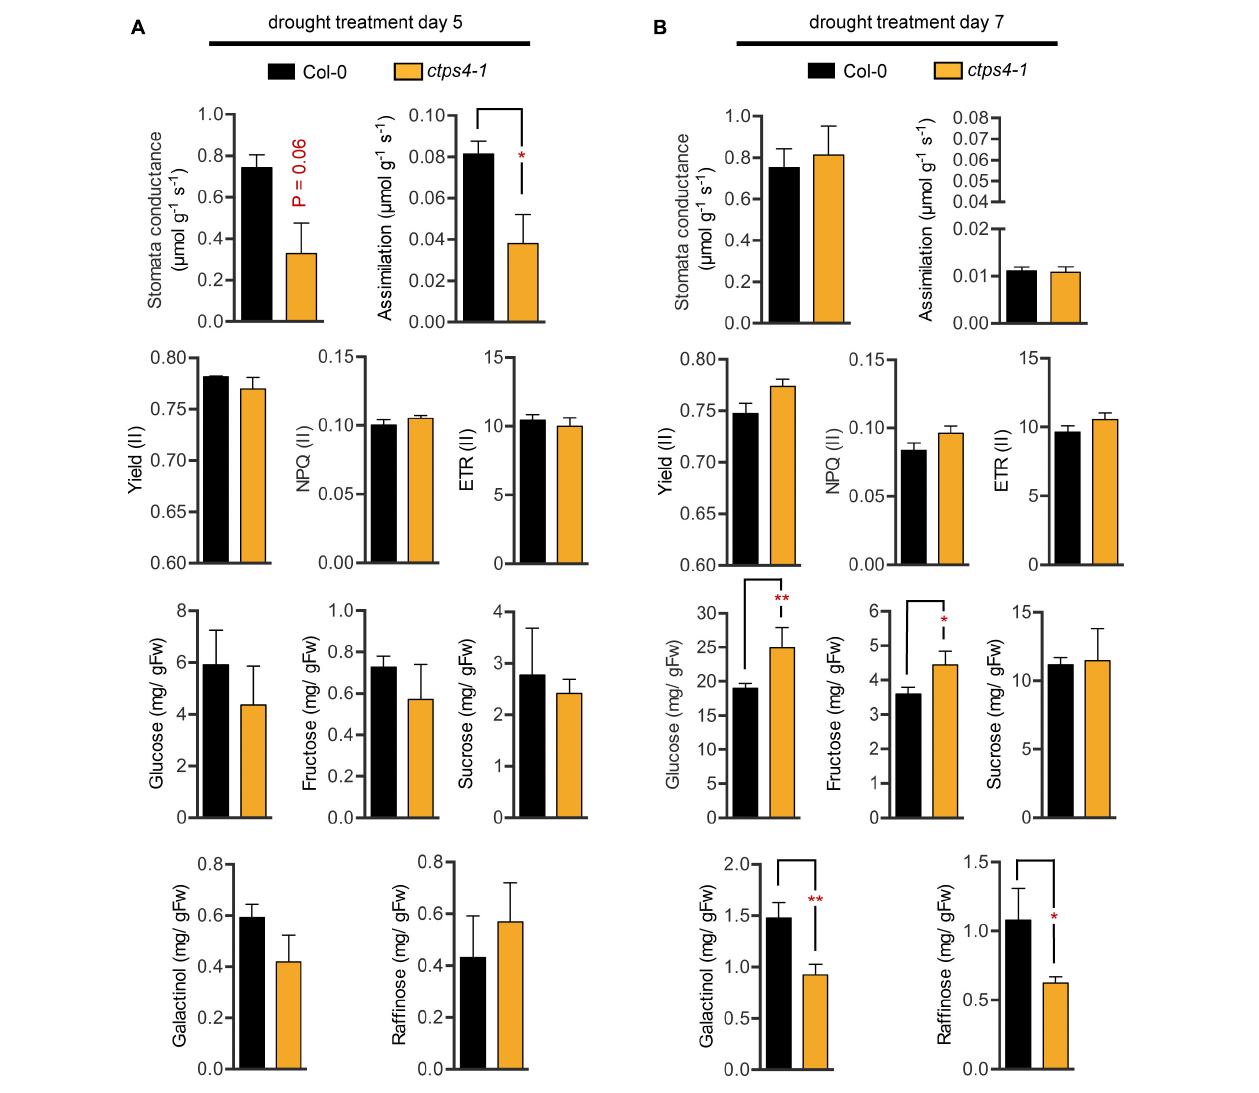
FIGURE 4 | Comparison of different physiological parameters between wild type (WT) and ctps4-1 after 5 and 7 days of pDR. Indicated parameters were determined after (A) 5 days pDR and (B) 7 days pDR. Stomata conductance, CO 2 assimilation, and photosynthetic parameters were measured by non-invasive methods (gas exchange, fluorescence imaging). Whole rosettes were harvested and extracted for sugar quantification. Effective quantum yield (II) [Yield (II)], non-photochemical quenching [NPQ (II)], electron transport rate [ETR (II)]. Plotted are the means of n = 3 biological replicates ± SE. For statistical analysis, Student’s t -test was performed (* p < 0.05, ** p < 0.01; n.s. no